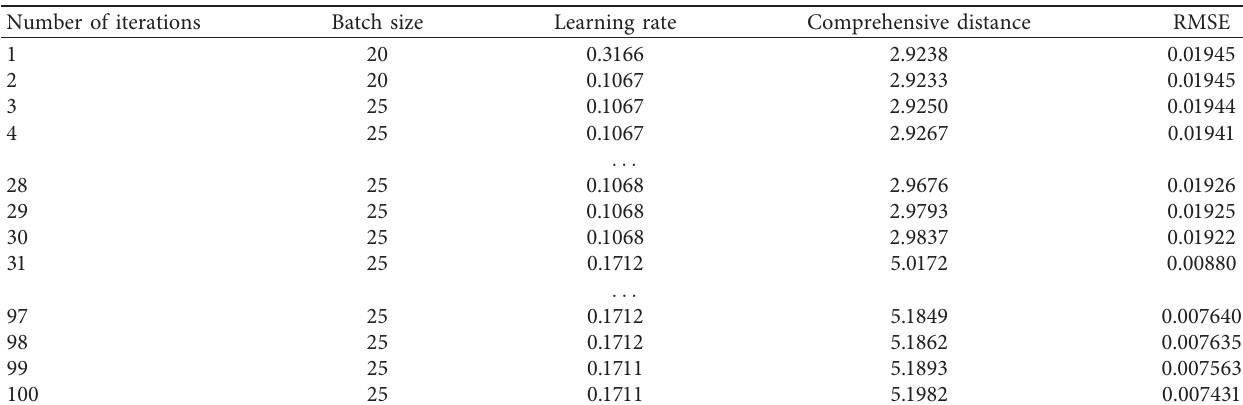
Figure 8: Comparison of fault feature sparsity between networks: (a) before optimization and (b) after Table 5: Iteration process.